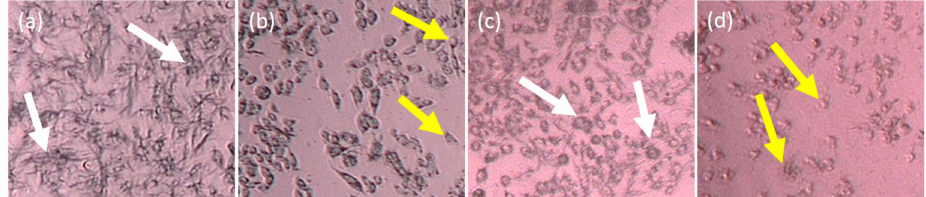
Figure 4. The cell morphologies after and before treatment with IC n -hexane as follows: ( a ) untreated T47D, ( b ) treated T47D, ( c ) untreated 4T1, and ( d ) treated 4T1. The white arrows indicate the normal living cells that form formazan crystals whereas the yellow arrows indicate the dead